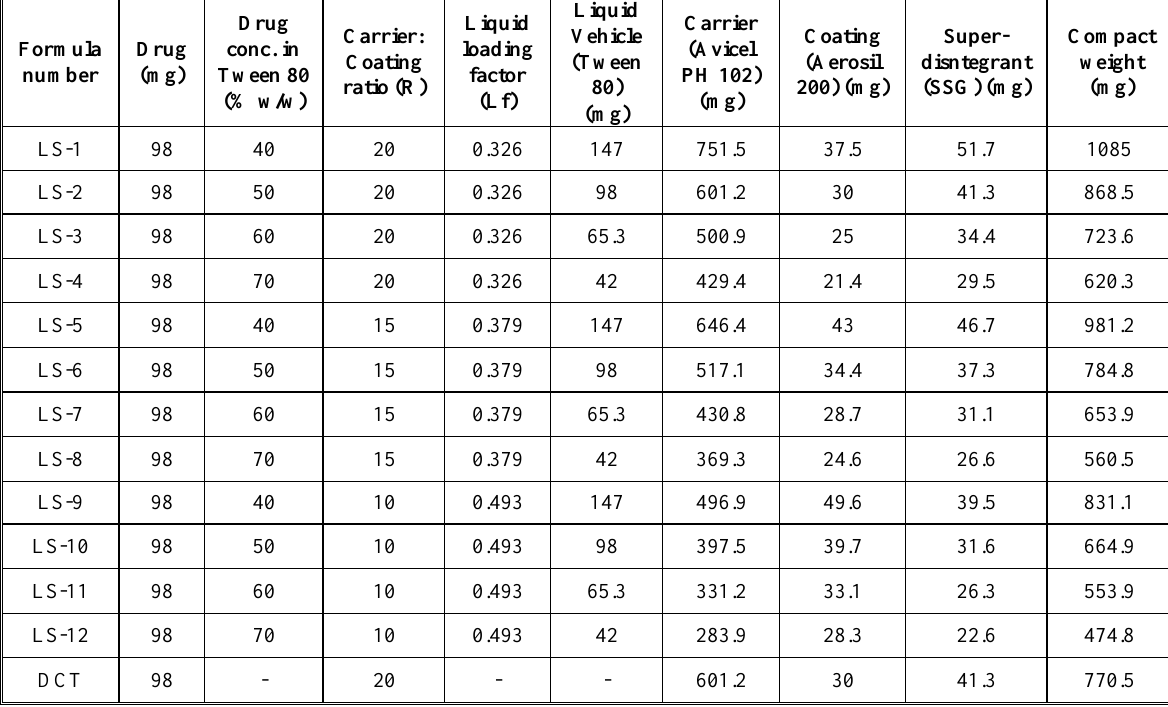
Table 1. Composition and characteristics of clopidogrel compact (LS) and DCT. Formula